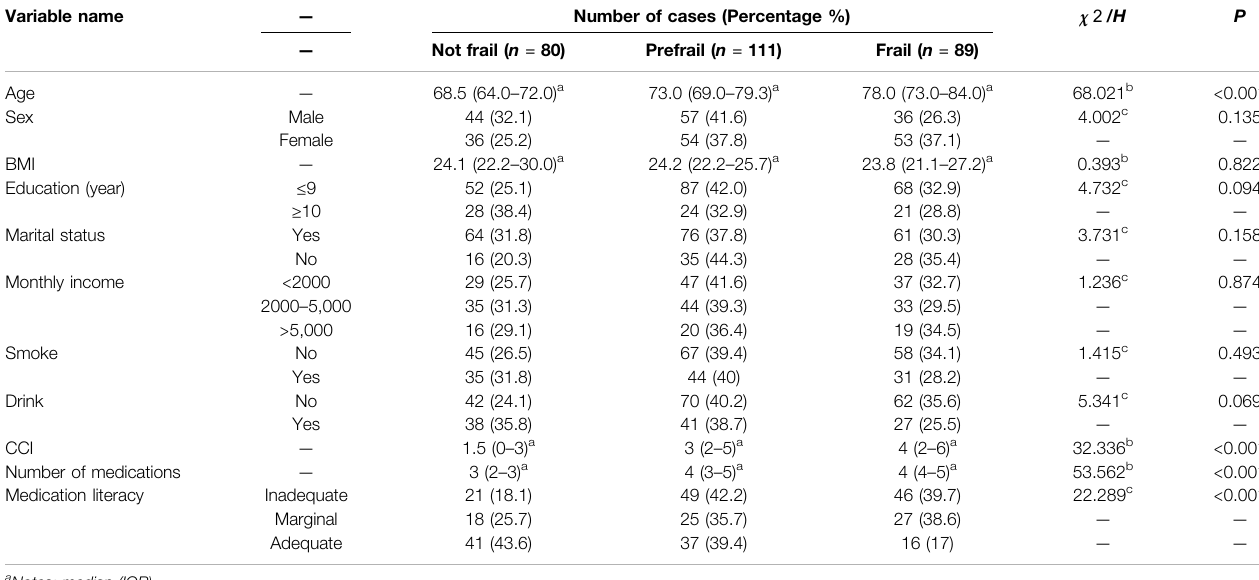
TABLE 4 | | Results of univariate analysis of frailty determinants for inpatients with CHD ( N (cid:1) 280).